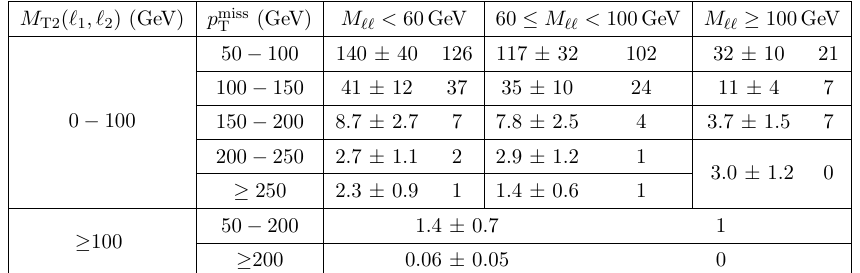
Table 15 . Category D: expected and observed yields in events with an opposite-sign e (cid:22) pair and one (cid:28) h . For each bin, the (cid:12)rst number corresponds to the expected yield and its uncertainty, and the second denotes the observed yield. The uncertainty denotes the total uncertainty in the yield.